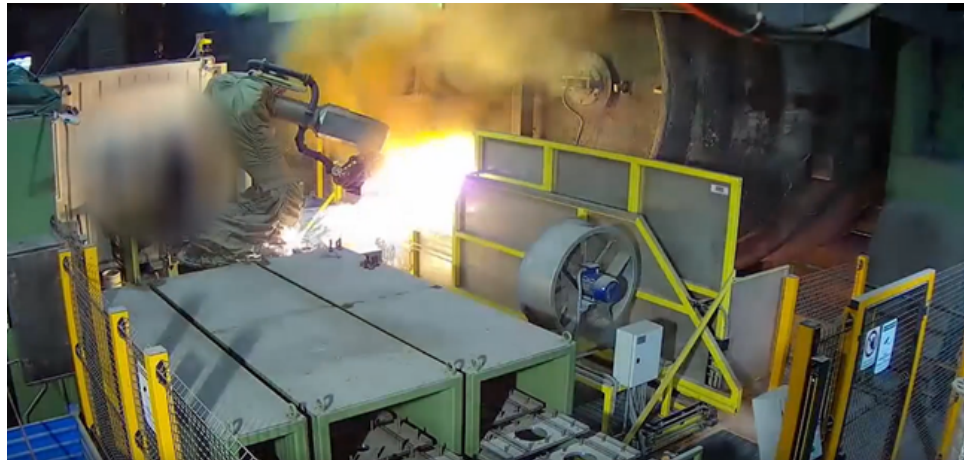
Figure 11. The robot opens the tap hole using an oxygen lance.